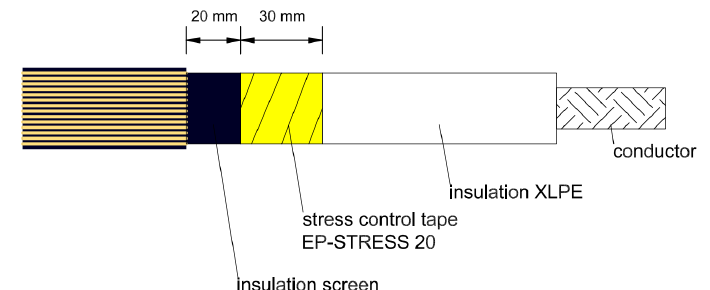
Figure 5. Correct assembly of the EP-STRESS 20 control strip according to the assembly instructions for the Energy Partners heat shrink termination type 24-EPOT-1/70-240/(U).